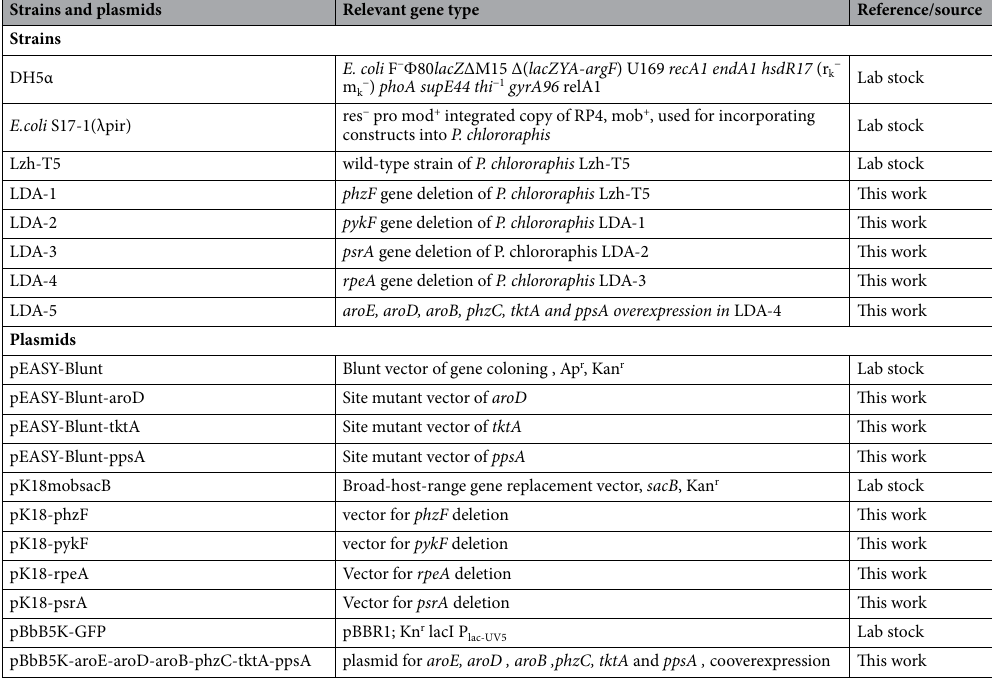
Table 1. Strains and plasmids used in this